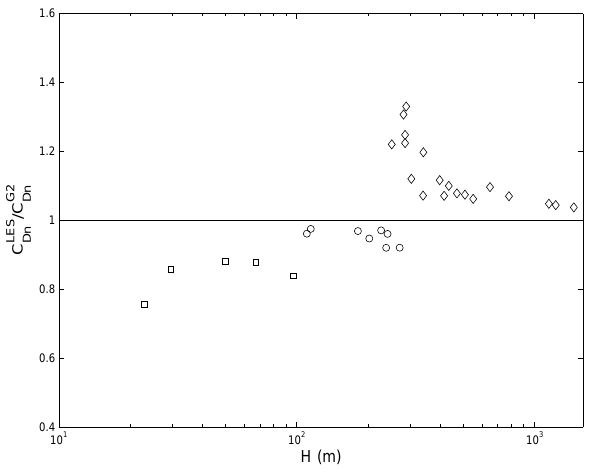
/C G 2 on the PBL depth H . C G 2 Dn Dn